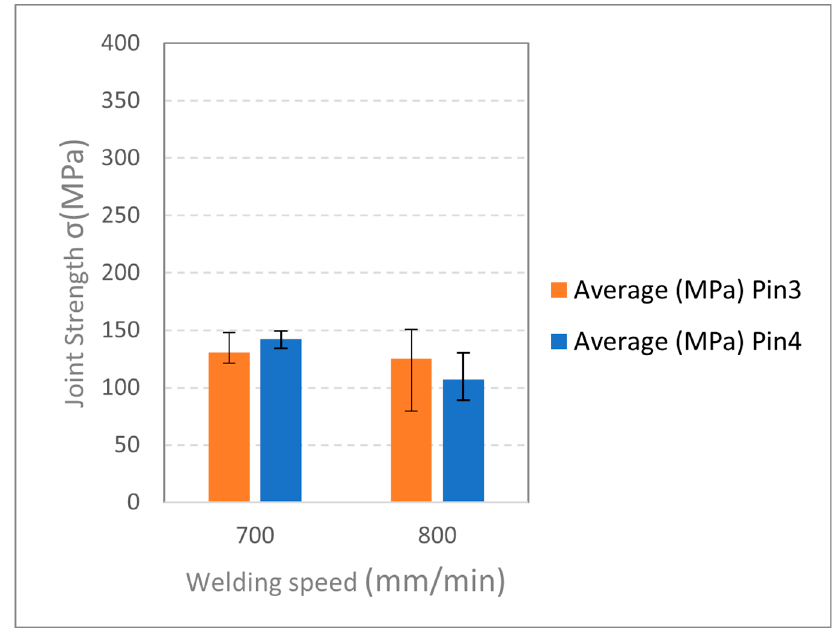
Figure 8. Comparison of Pin3 and Pin4 tool at 2500 rpm.